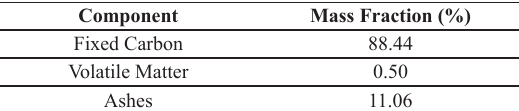
Table 2. Composition of the coke sample (% by mass